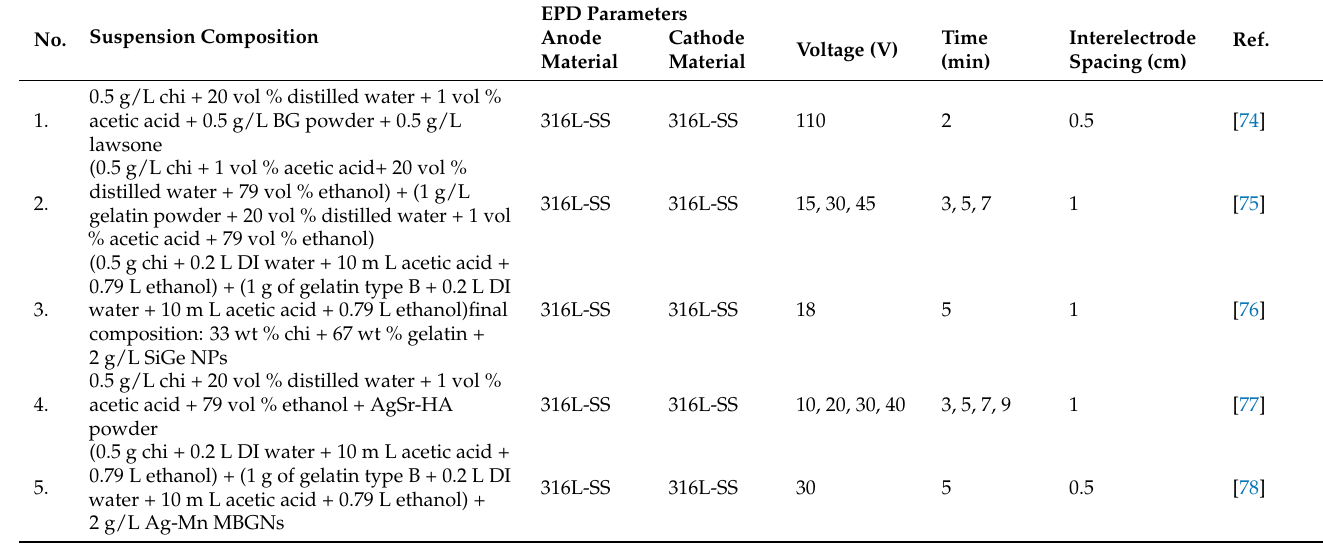
Table 1. EPD parameters for chi (No. 1–9)-, zein (No. 10–14)-, and PEEK (No. 15–33)-based